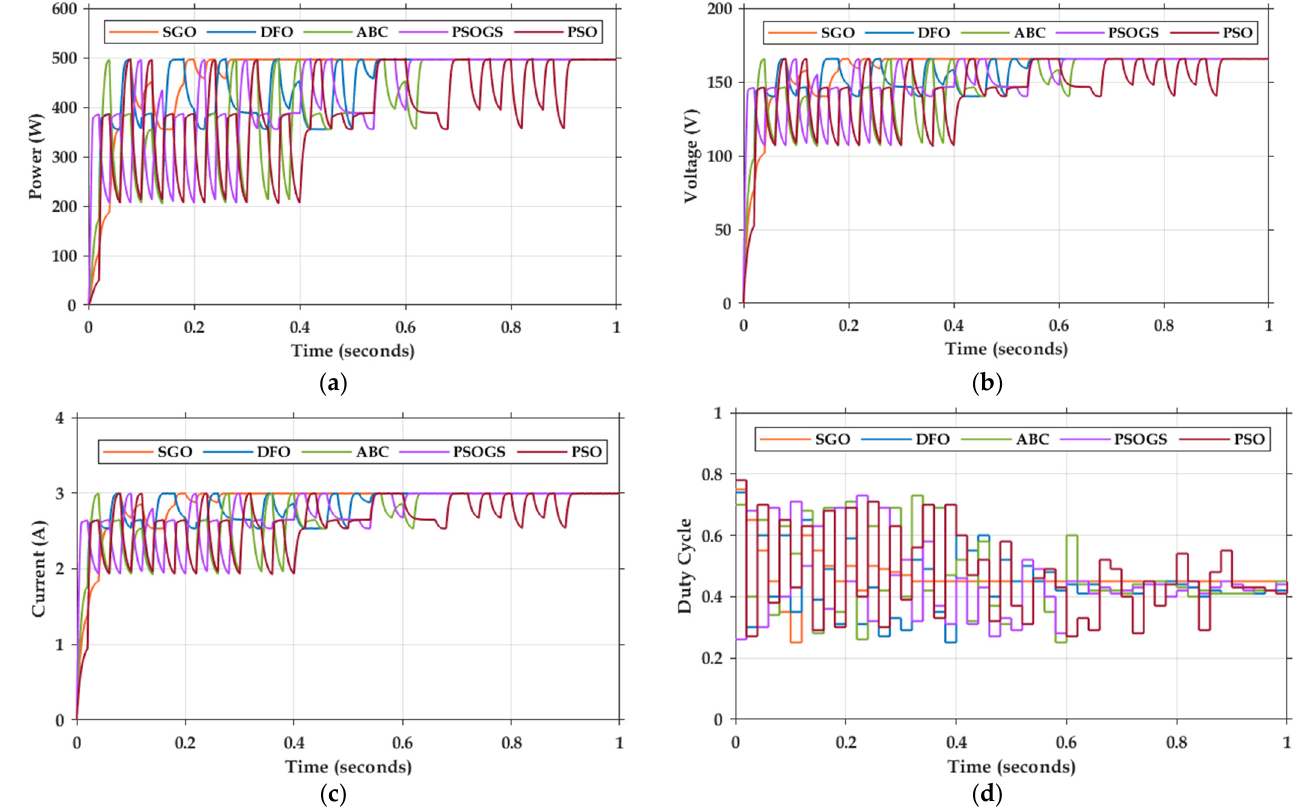
Figure 10. Case 2: comparison of ( a ) power, ( b ) voltage, ( c ) current, ( d ) duty cycle of SGO, DFO, ABC, PSOGS, and PSO.